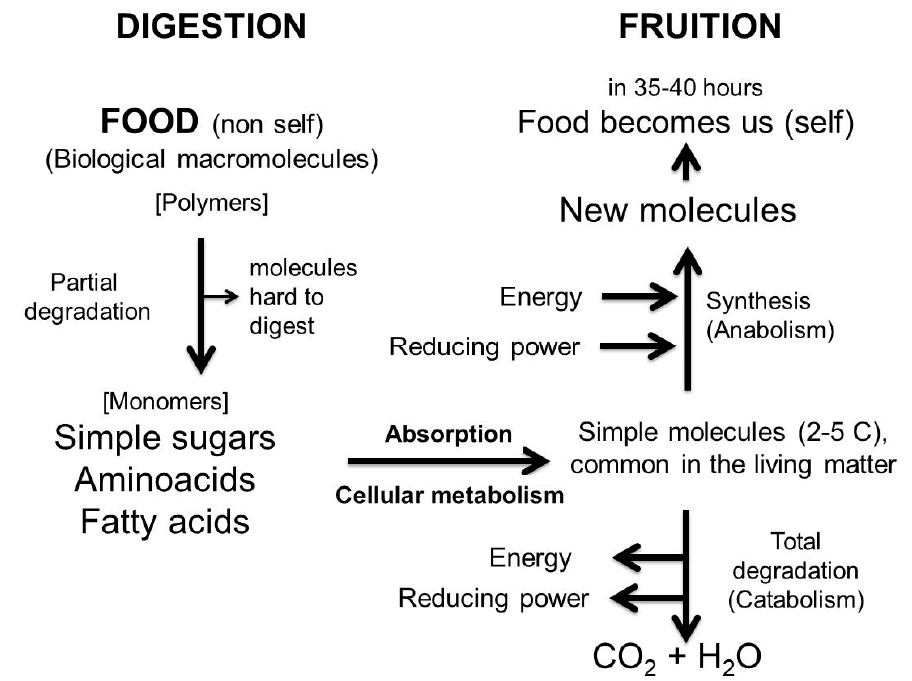
Figure 6. Schematic representation of the metabolic processes, from digestion of the simplest molecules, common to all living organisms and to their fruition.